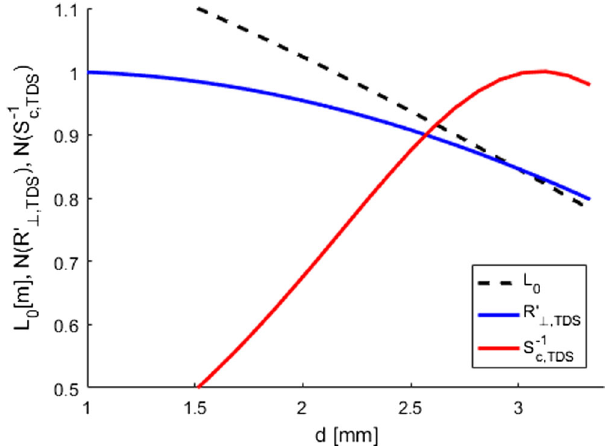
FIG. 11. Effective transverse shunt impedance per meter length of the TDS with BOC R 0 ⊥ (solid blue line) and inverse of the ; TDS maximum modified Poynting vector in the TDS S − 1 (solid red c; TDS line) as functions of the iris thickness d . Both are normalized to its maximum value. In addition, the optimum TDS length L 0 versus the iris thickness is also shown (dashed line).